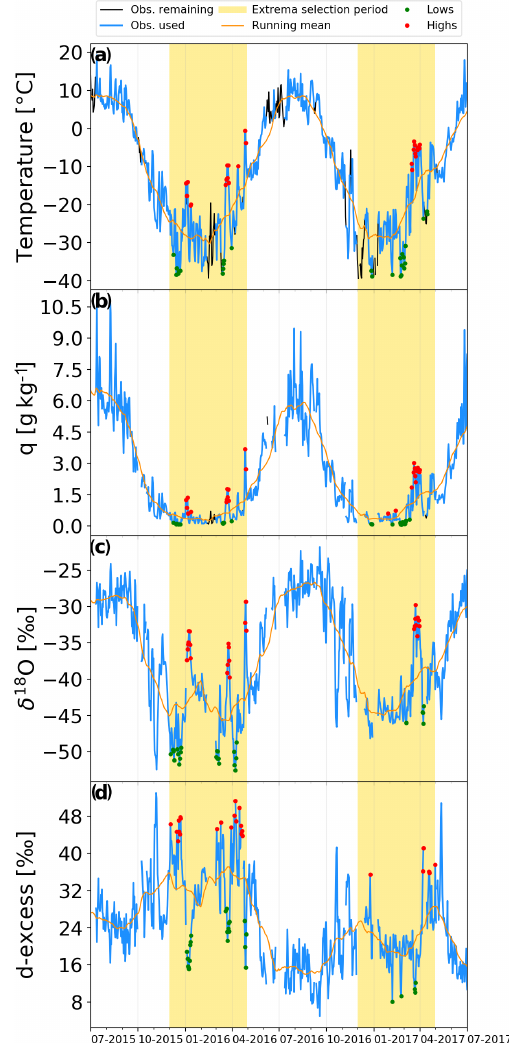
Figure 9. Time series of (a) temperature, (b) specific humidity, (c) δ 18 O v and (d) d -excess v . The daily averaged data are depicted in blue for the data used to compute the 60d running average (orange line) and in black for the remaining data (not used in the running average calculation). The yellow shading represents the period over which extrema (depicted as red and green dots for high and low extrema, respectively) are considered: from December to April for each year.